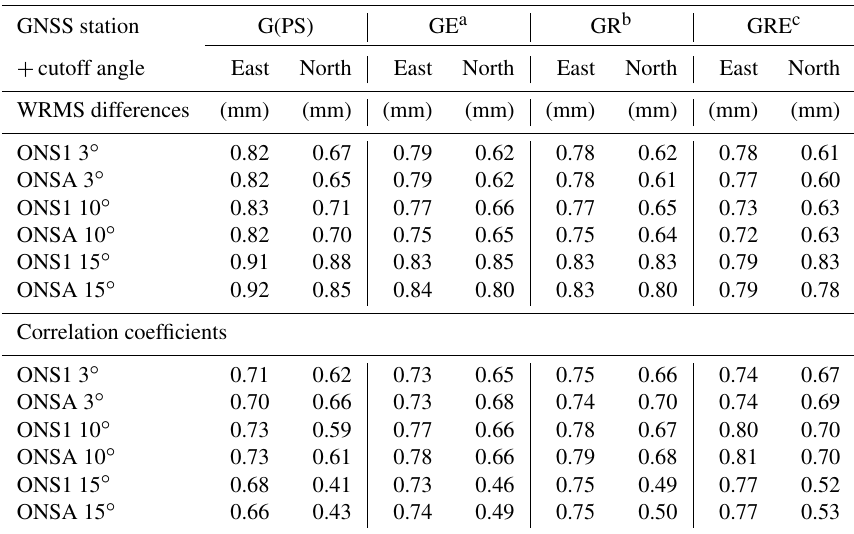
Figure 6. Correlations between estimated gradients from the GNSS and the WVR data calculated for each month. Table 3. The WRMS differences and correlations of the east and the north gradients, obtained from different satellite constellations, relative to the WVR data for June and July